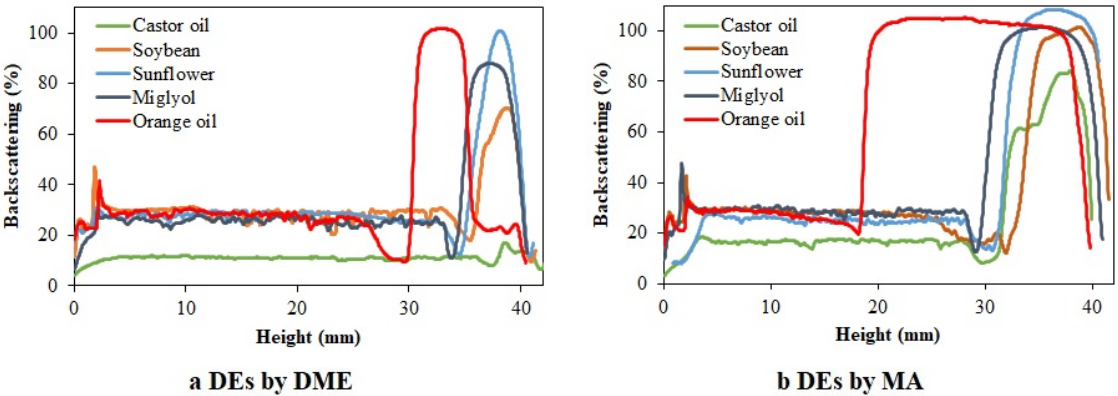
Figure 6. Backscattering profiles of DEs after 20 days of storage. ( a ) DEs prepared by DME; ( b ) DEs prepared by MA.